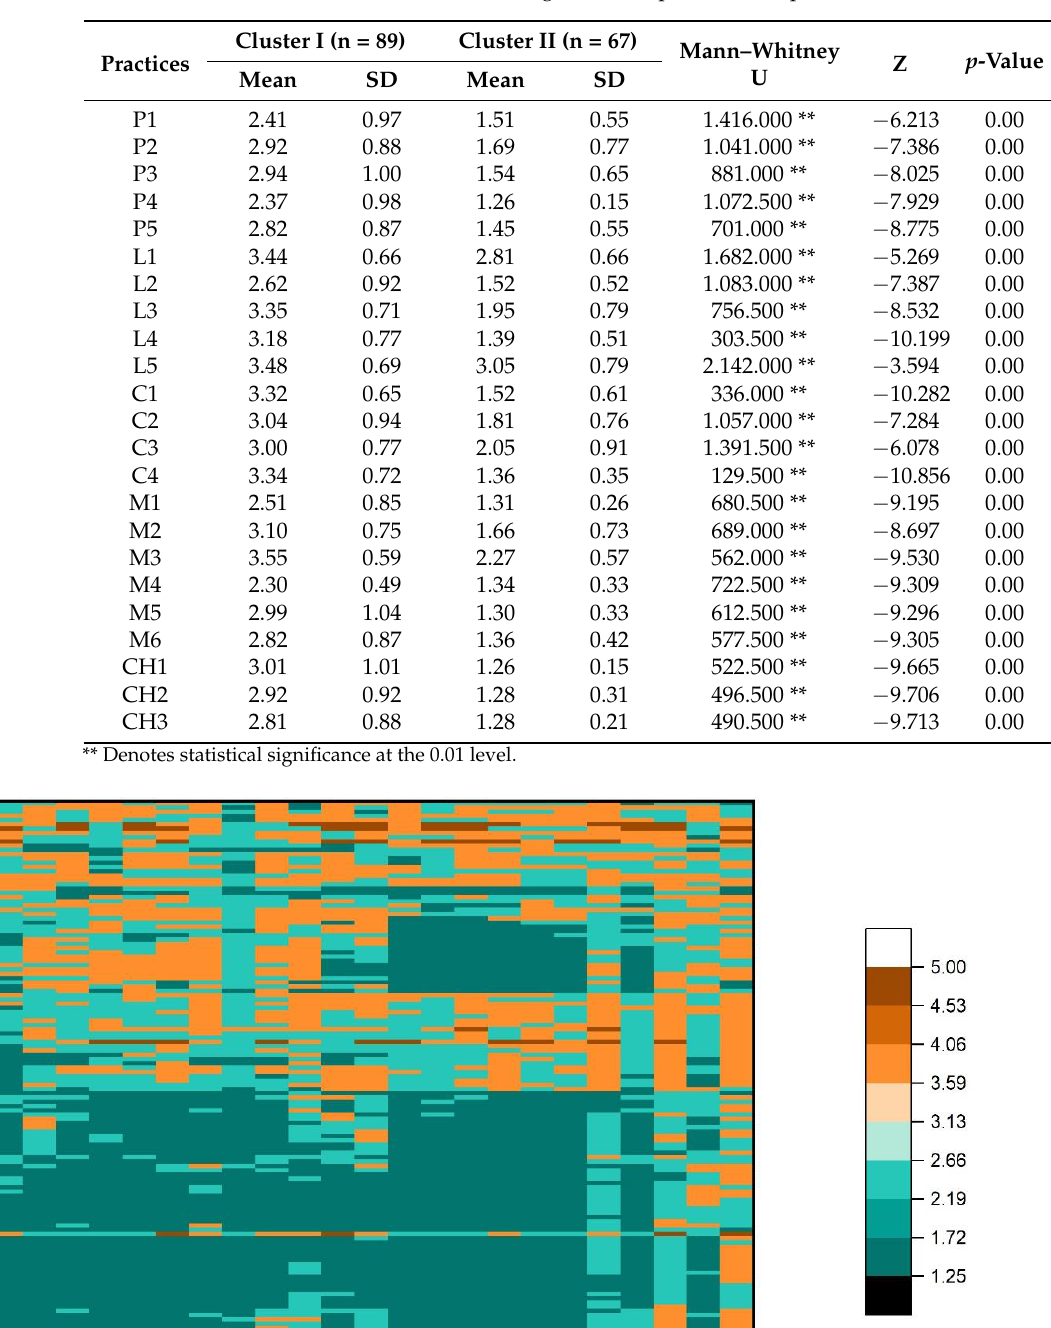
Table 4. Differences between clusters according to the adoption of IPM practices for RPW control.